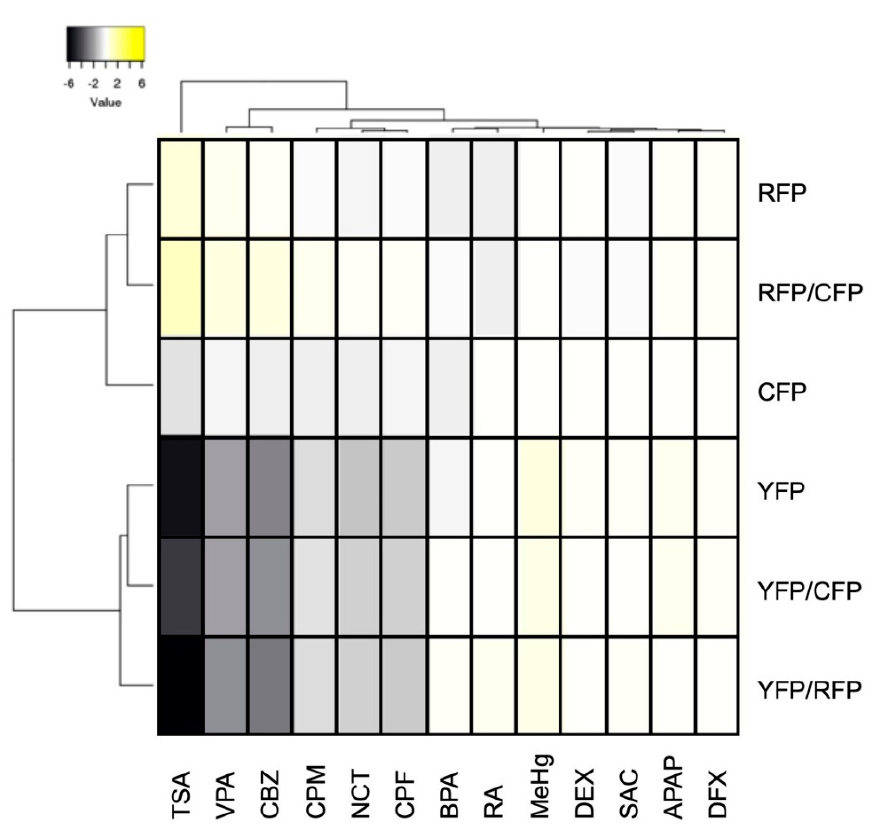
Figure 5. Hierarchical clustering of chemicals based on their effects on Cerulean (CFP), mCherry (RFP), and mCitrine (YFP) expression in triple-Tg zebrafish. The normalized score of six fluorescence parameters (CFP, RFP, YFP, RFP/CFP, YFP/CFP, and YFP/RFP) from triple-Tg zebrafish exposed to chemicals at their MTC from 12 hpf to 5 dpf were subjected to hierarchical clustering using Manhattan distance with average